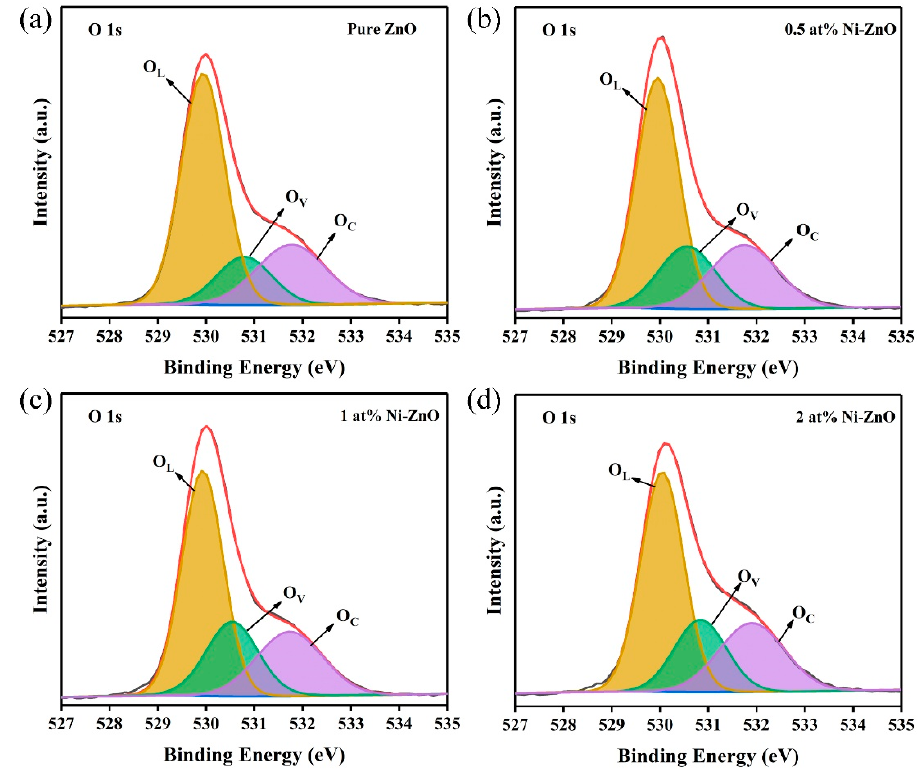
Figure 6. The XPS spectra of O 1s for ( a – d ) pure, 0.5, 1, and 2 at%